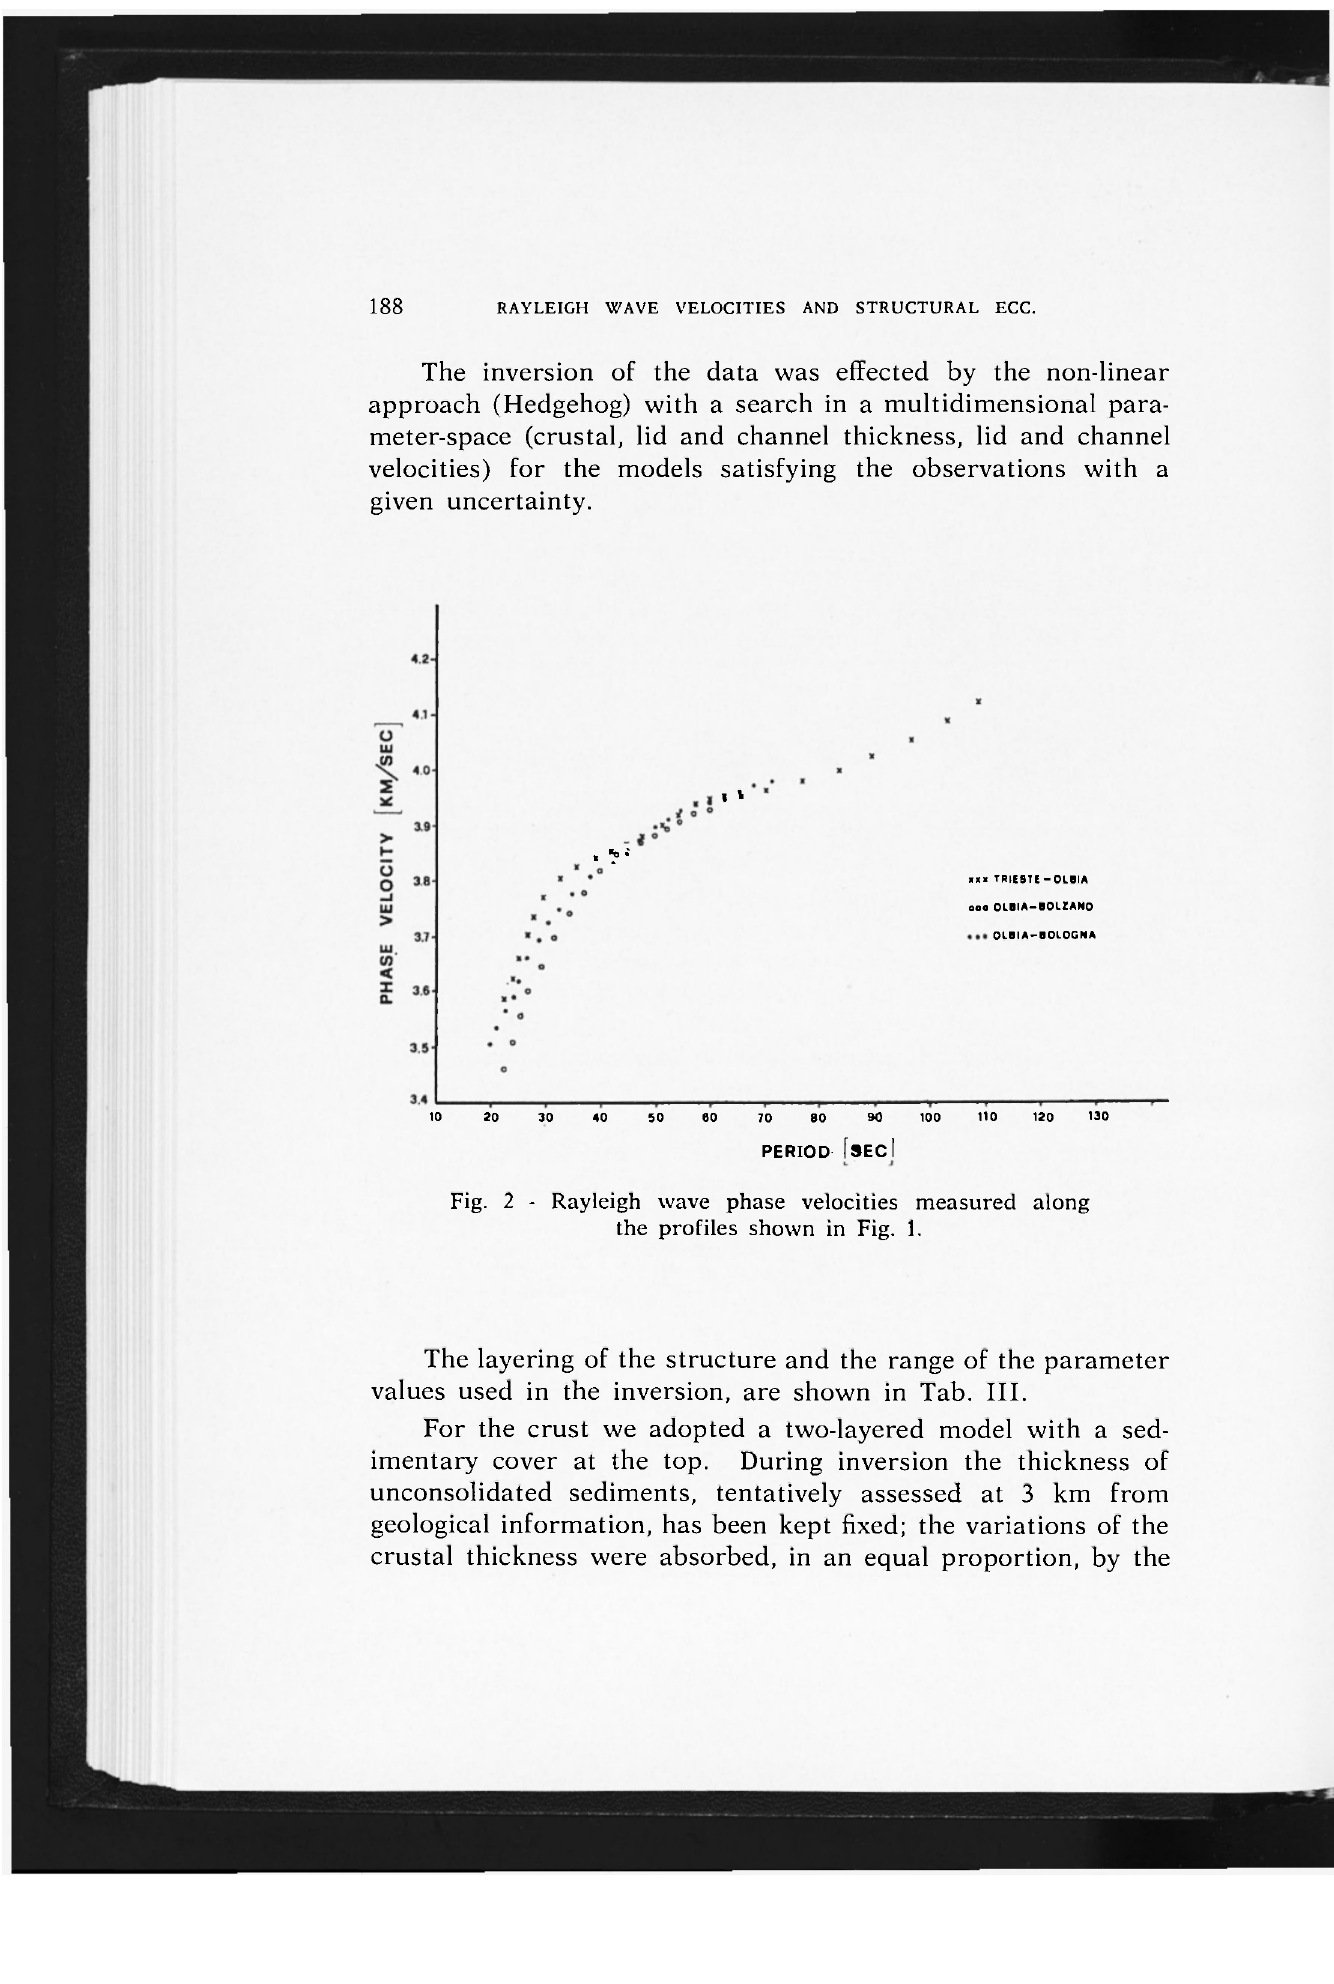
Fig. 2 - Rayleigh wave phase velocities measured along the profiles shown in Fig.